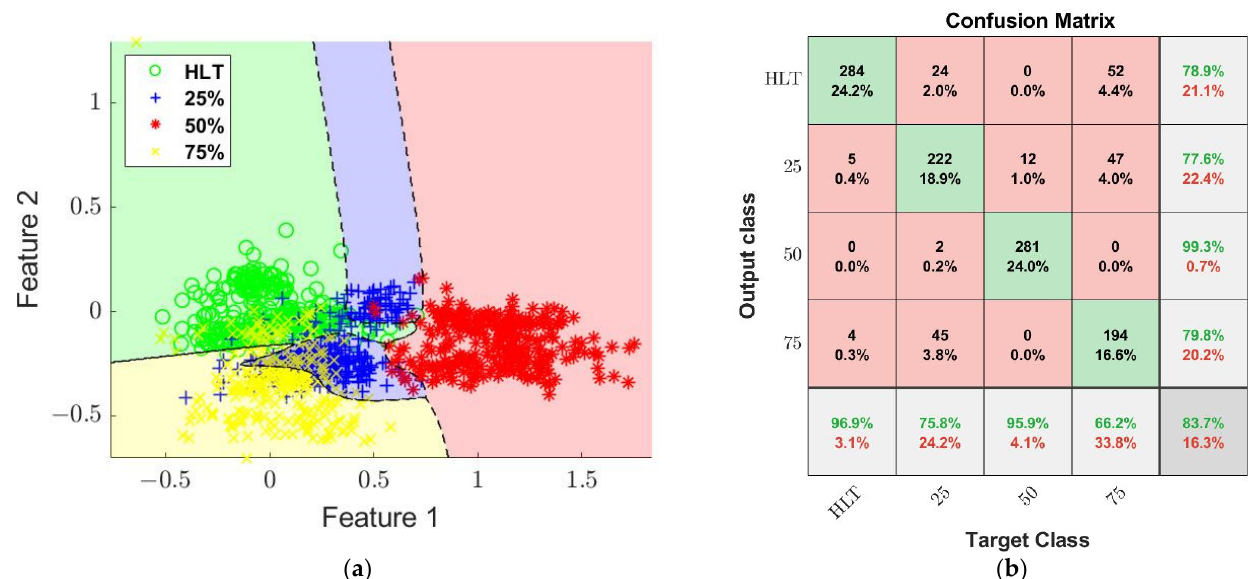
Figure 9. Features optimization through GA for Ay and Az vibration signals (not data fusion is considered), in ( a ) Two-dimensional projection of clusters (fault conditions) through LDA with limit bounds, and ( b ) Confusion matrix that validates the ANN classification of faults.